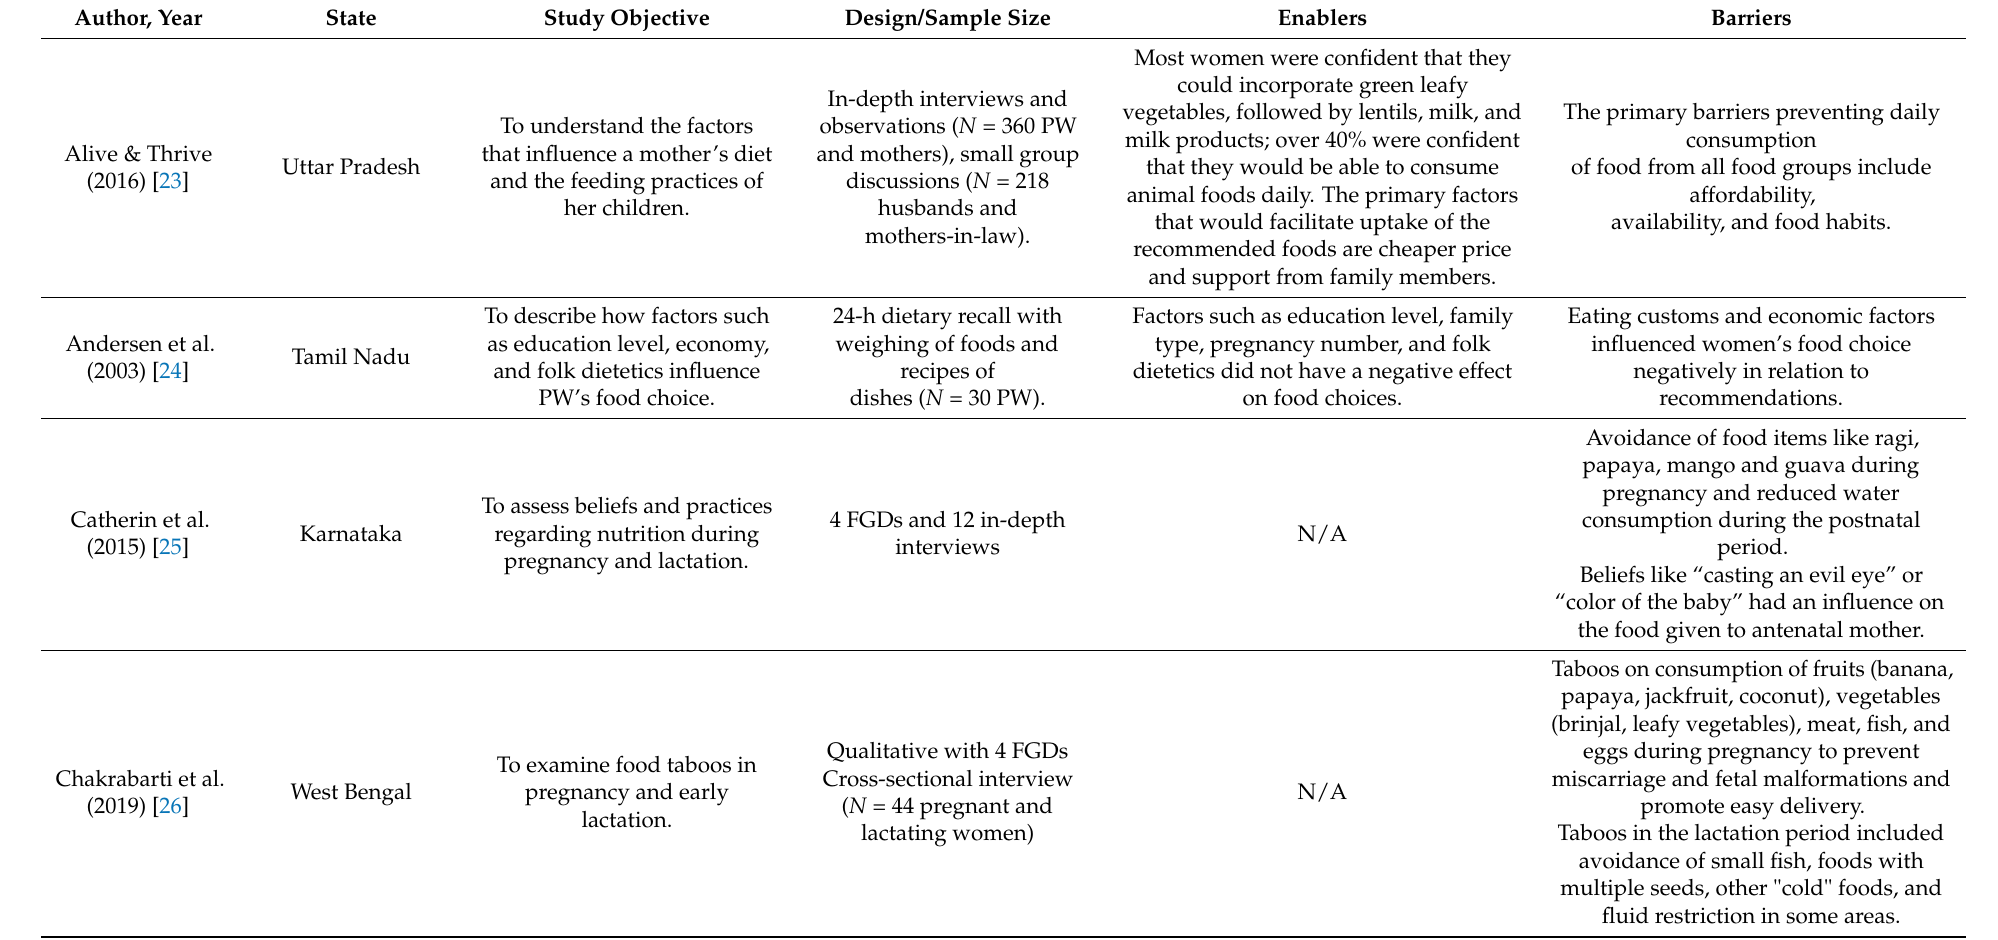
Table 3. Summary of enablers of and barriers to optimal diets from subnational